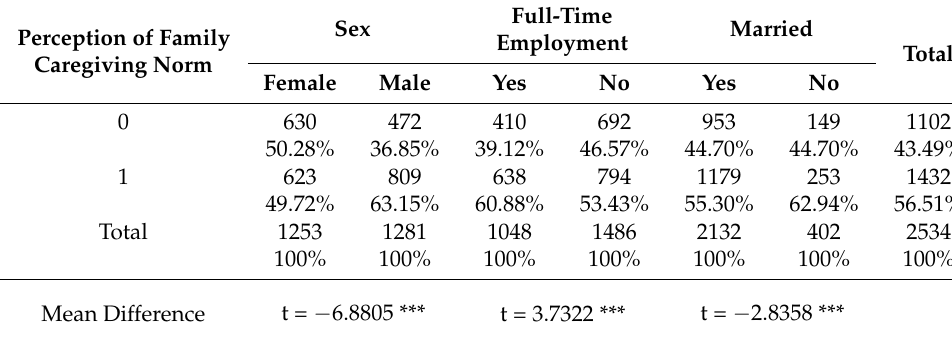
Table 4. Perceptions of family caregiving norms by demographic characteristics. Perception of